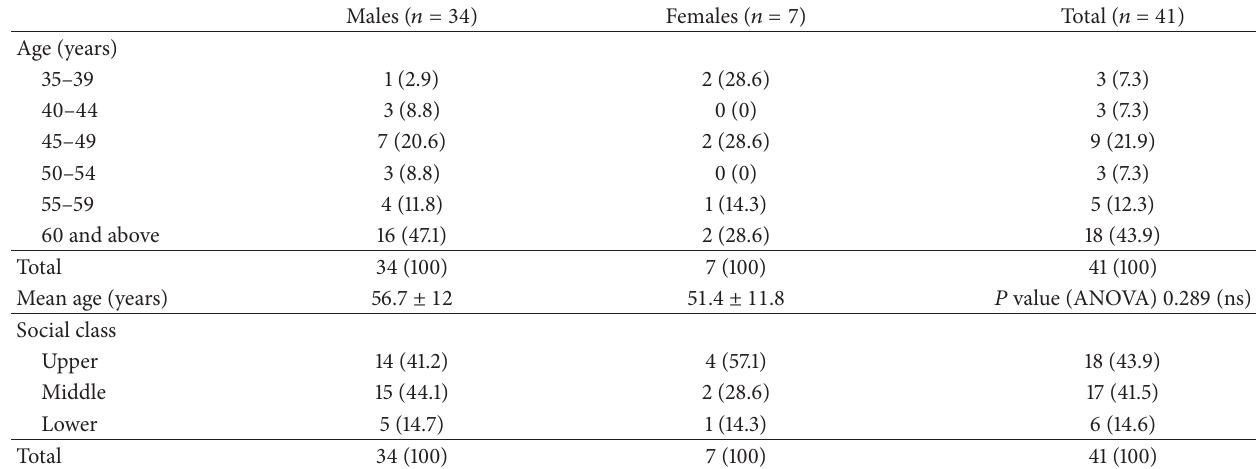
Table 3: Sociodemographic characteristics of clinical participants.